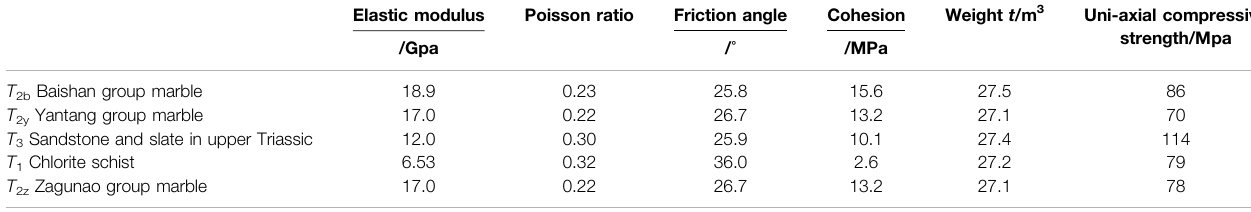
TABLE 2 | Strata physical and mechanical properties for the Jinping project.